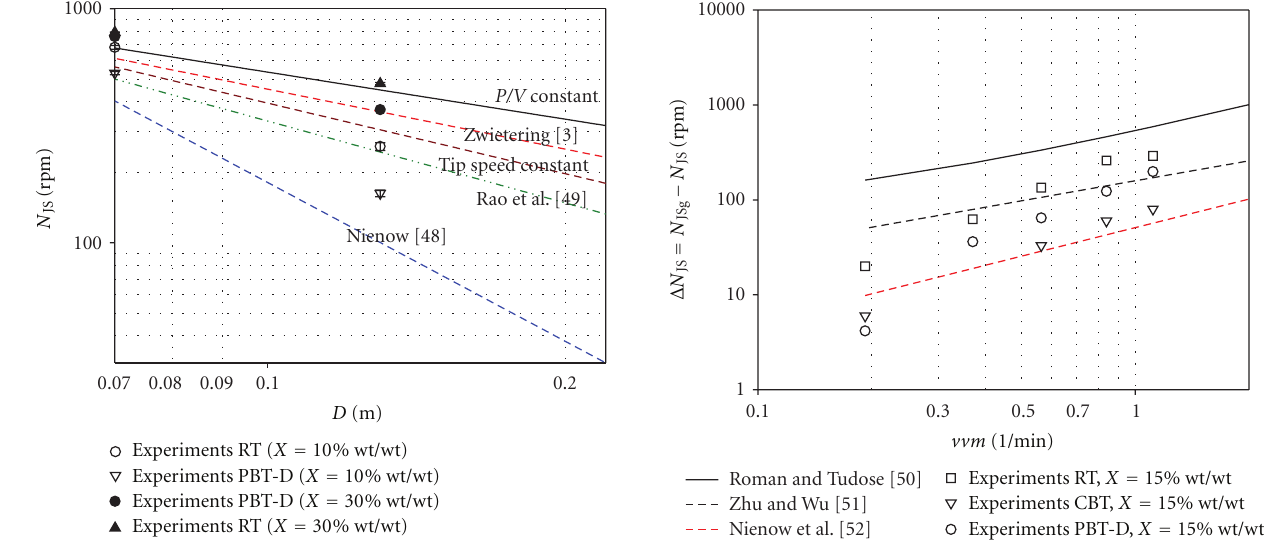
Figure 9: Variation of Δ N JS in gas-liquid-solid system by increasing gas flow rate: experimental data compared with correlations [50–